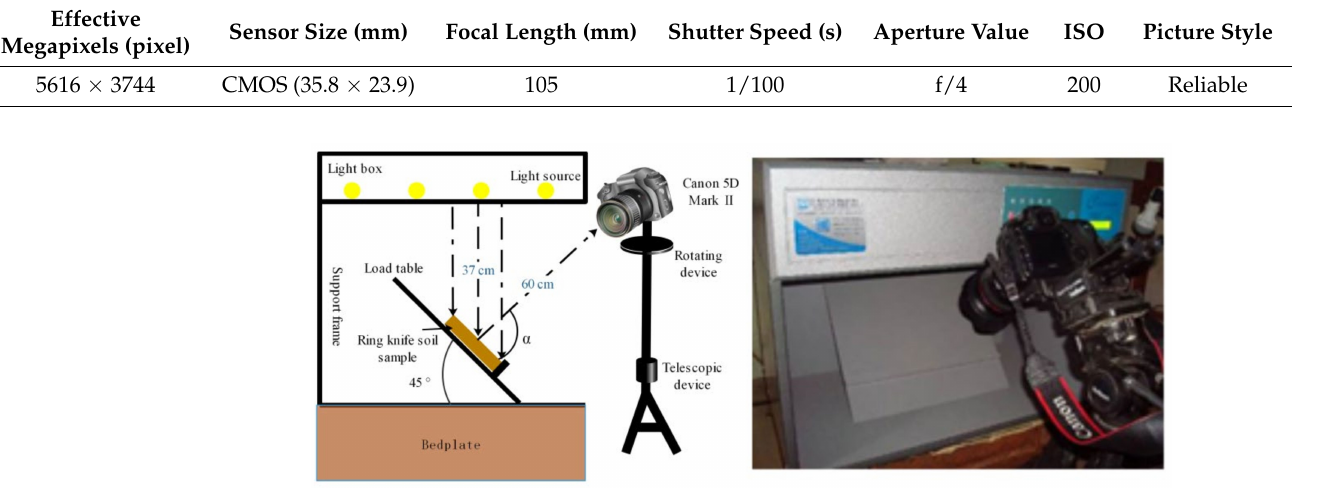
Table 2. Basic parameters of Canon 5D Mark II.